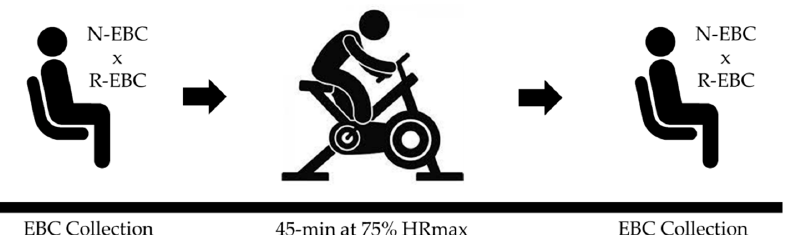
Figure 1. Experimental design. Exhaled breath condensate (EBC) collection (10 min) occurred immediately before and after the bout of exercise. A subset of participants ( n = 5) completed both a 10 min N ‐ EBC collection and a 10 min R ‐ EBC collection in a randomized fashion both before and after the bout of exercise.